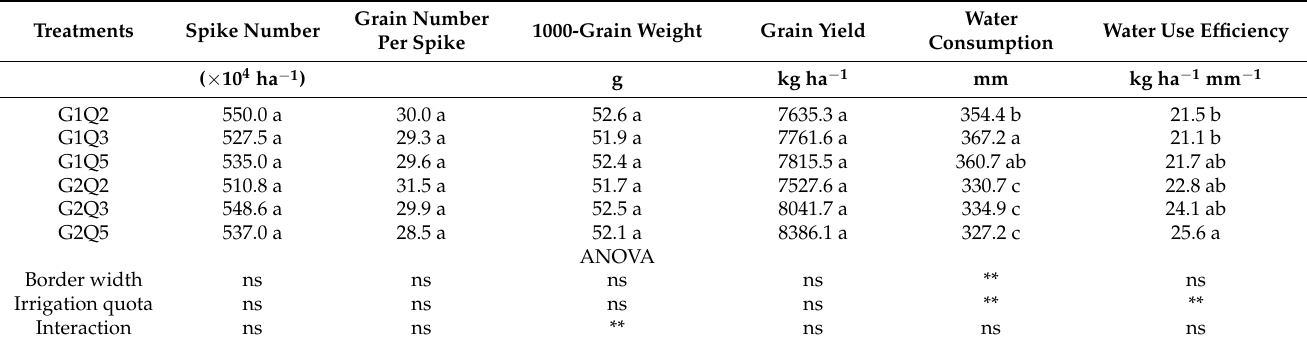
Table 4. Yield components, water consumption, and water use efficiency of winter